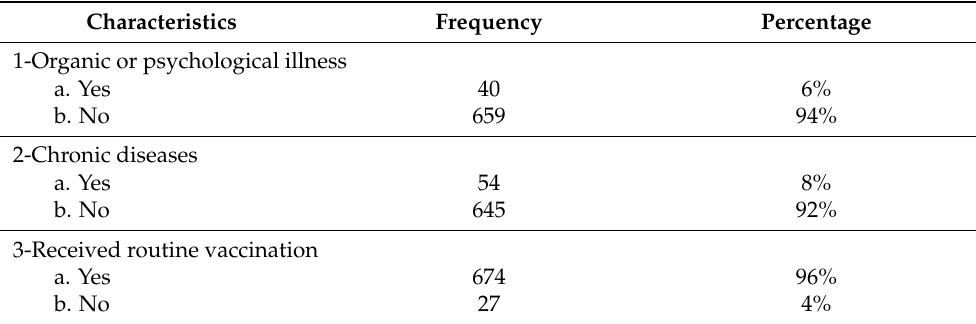
Table 2. Health status of the